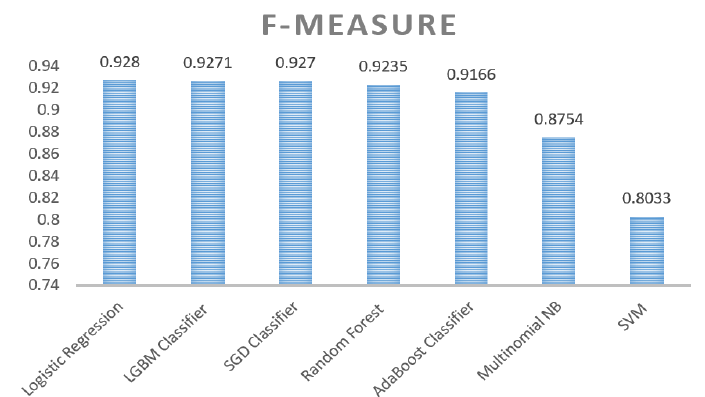
Figure 6. Comparison between the Best Classifiers in Terms of F-Measure.